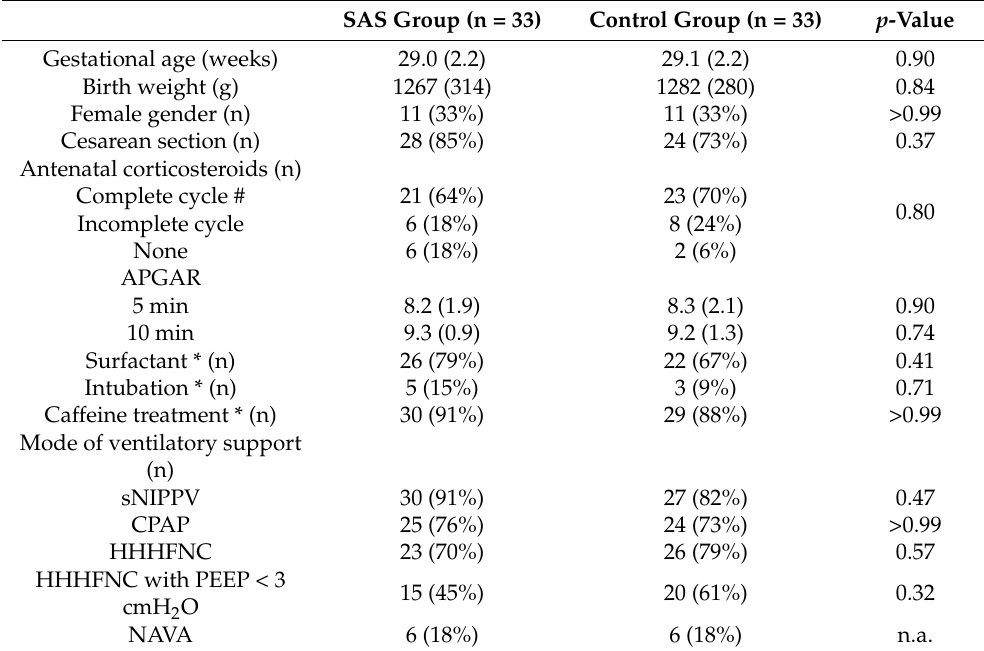
Table 1. Baseline characteristics and different NIV modes in the study